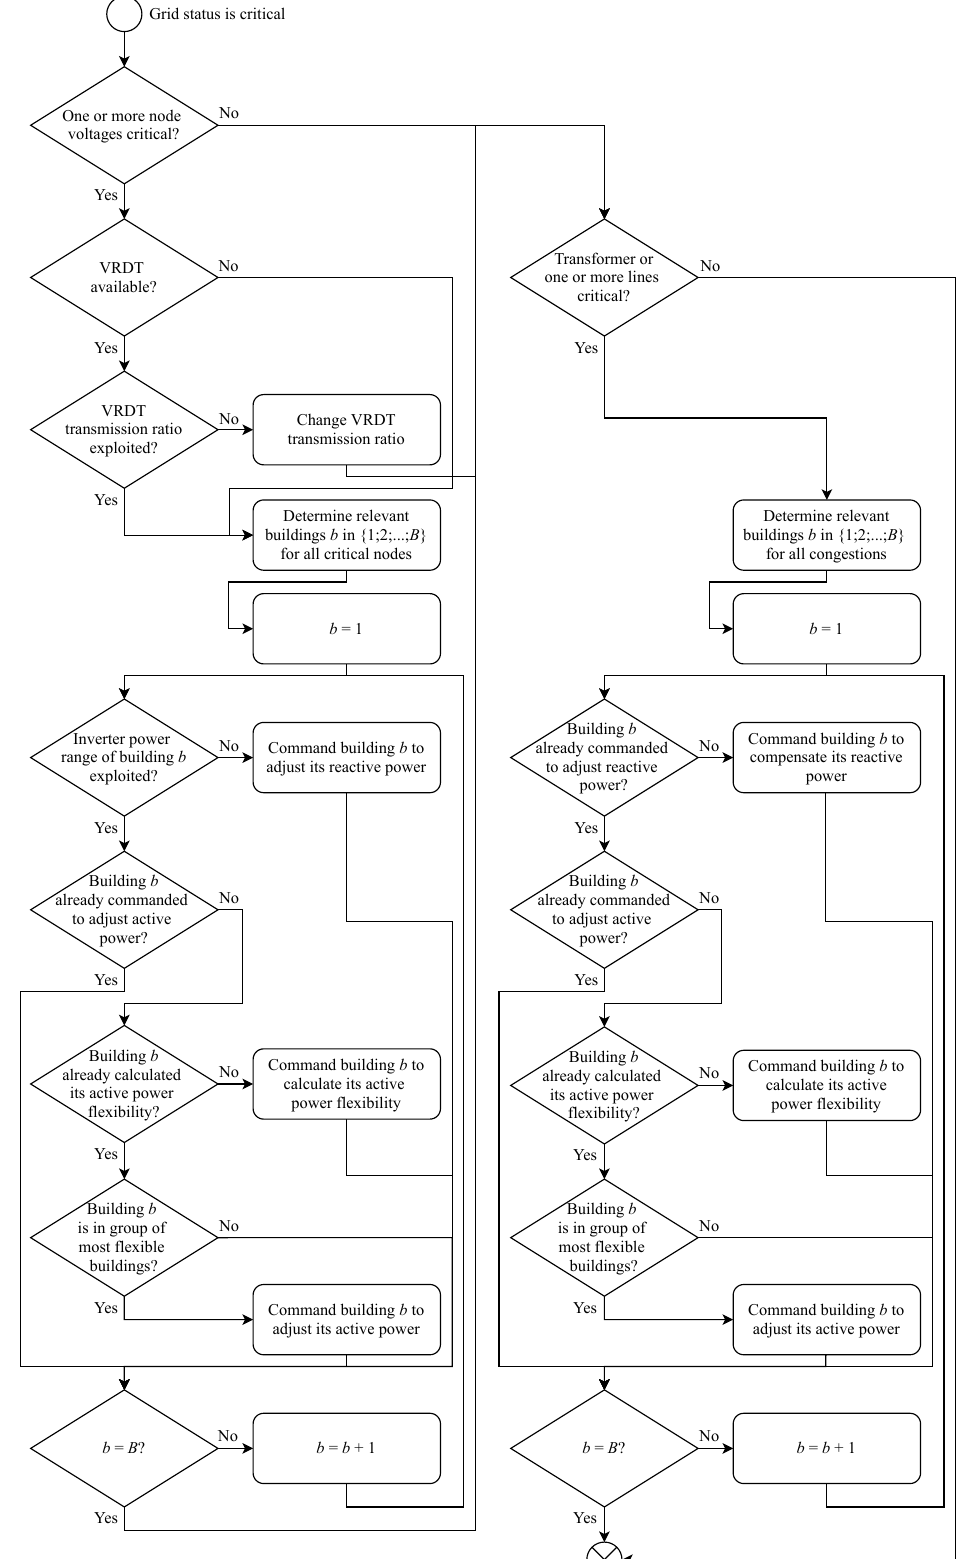
Figure 4. Cascades of measures against critical grid situations employed by the DSO for the controlled low-voltage grid in the centralized grid control strategy. While the general cascades of measures are partially adapted from ref. [11], this schematic is new and reflects our specific